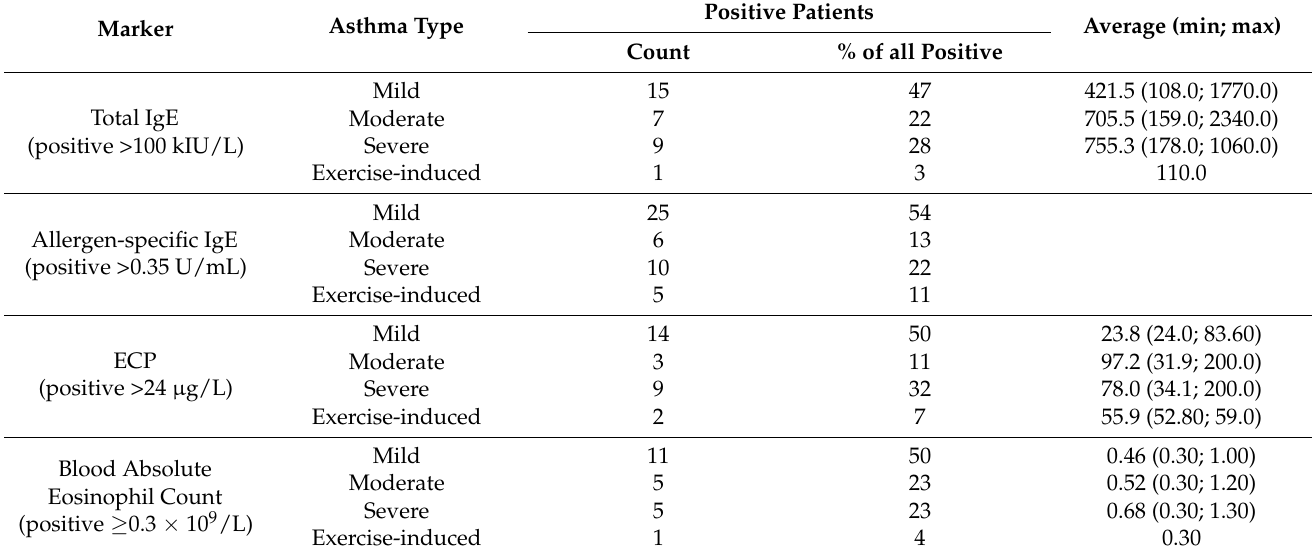
Table 4. Laboratory markers of allergy according to asthma severity.